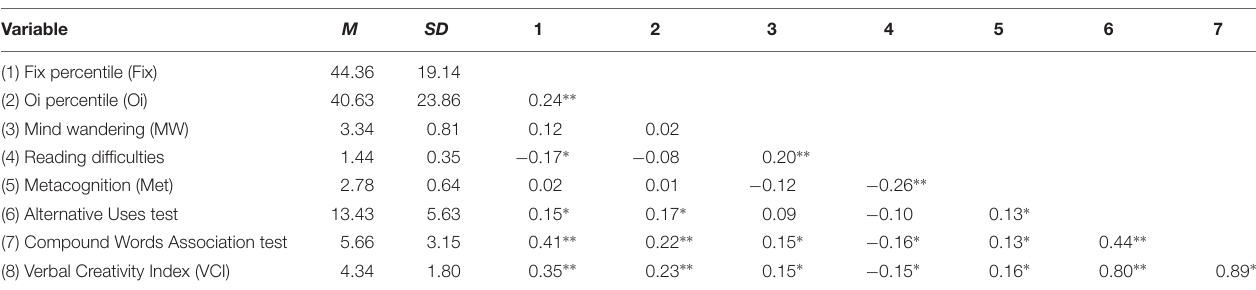
TABLE 1 | Means, standard deviations, and correlations